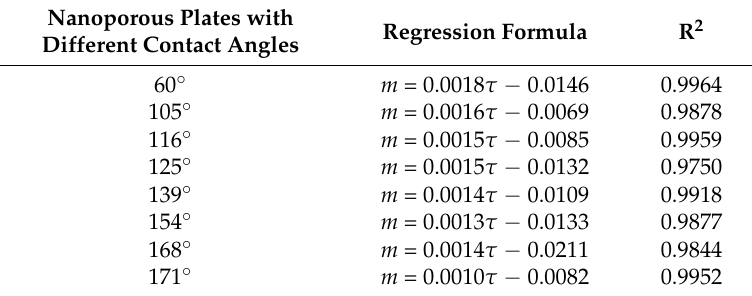
Table 2. Fitting model formula between frost weight and